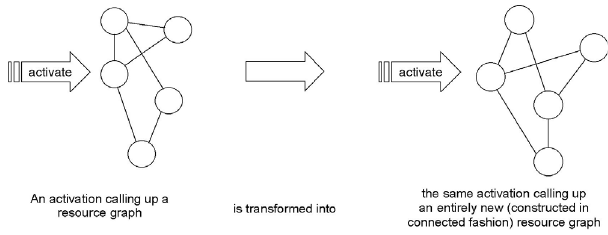
FIG. 8. Network-cascade change. A change within a network leads to a series of